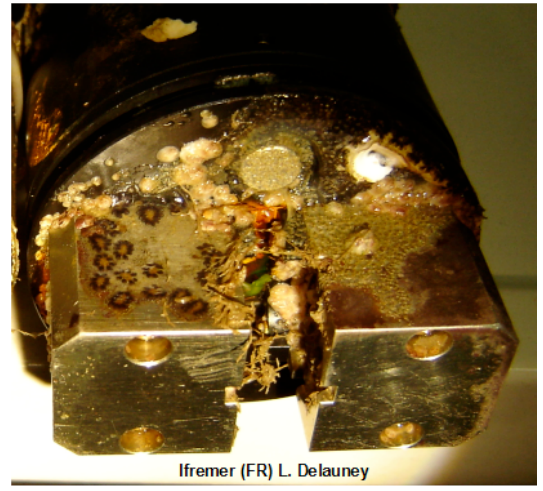
Fig 1 : Fluorometer after Fig 2 : Transmissometer after Fig. 1. Fluorometer after 30 days in Helgoland (Germany) during 30 days in Helgoland (Germany) 40 days in Trondheim summer. during summer harbour (Norway) during summer